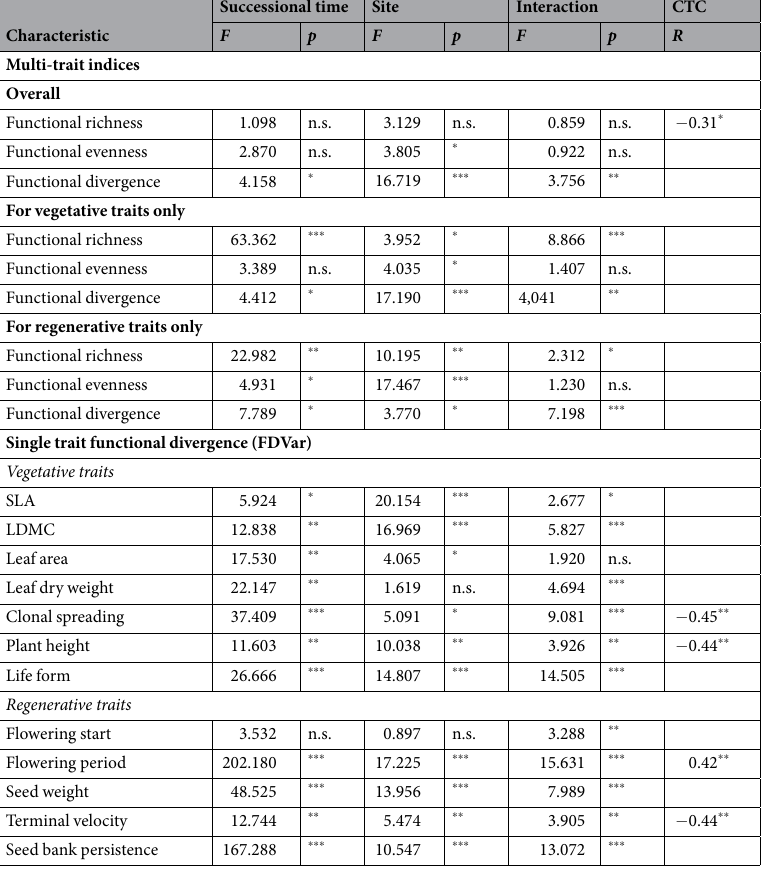
Table 2. Effects of site and successional time on the functional diversity and single-trait functional divergence of recovering sand grasslands. Two-way repeated measure GLM with ‘site’ as fixed and ‘successional time’ as repeated measure factor. Notations: CTC – correlation with total cover (Spearman rank-correlation). Significance levels: n.s. = non-significant; * 0.01 ≤ p < 0.05; ** 0.001 ≤ p < 0.01, *** p < 0.001. For the nominal traits (pollination types) single-trait functional divergence was not